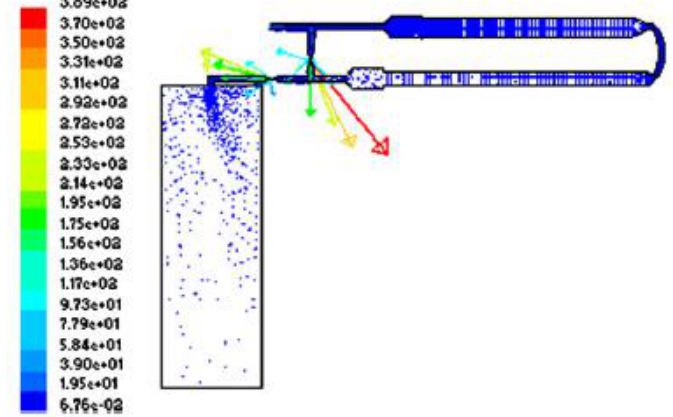
Figure 9. Velocity vector for the entire system.